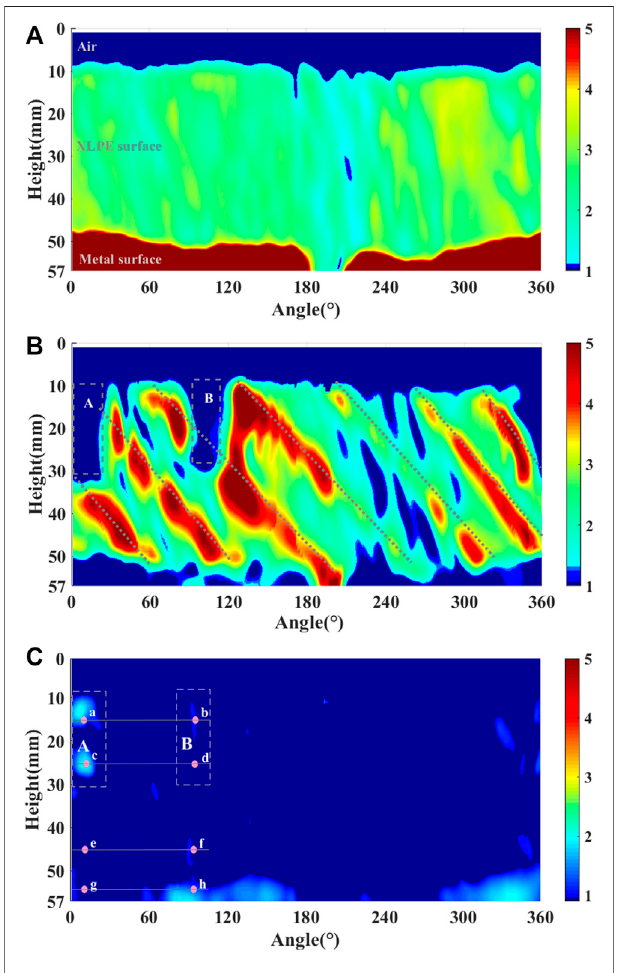
FIGURE 4 | THz C-scan images. (A) Outer surface of the cable; (B) interface of the conductor core; (C) depth position of holes.